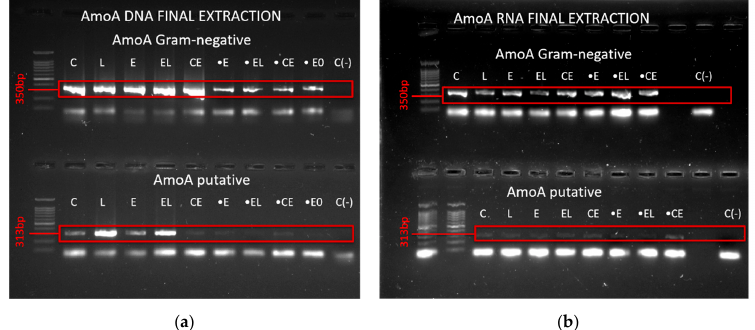
Figure 6. ( a ) Electrophoresis gel for Gram-negative and Putative amoA PCR products from final soil and worm tissue DNA extraction; ( b ) Electrophoresis gel for Gram (-) and Putative amoA PCR products from final soil and worm tissue RNA extraction.